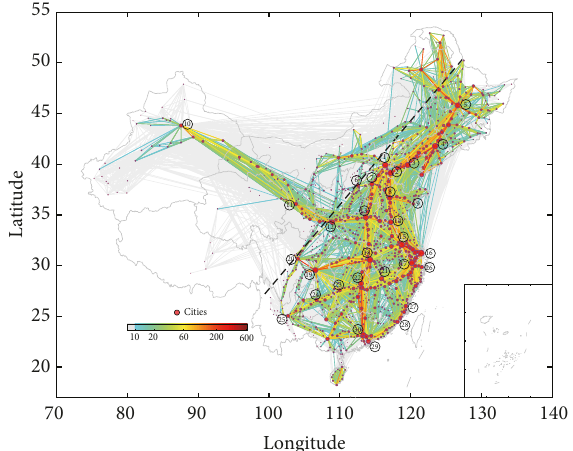
Figure 3: The spatial distribution of train flows in CRN. The size of the nodes reflects the degree of the city, and the colors of the lines indicate train flows. The black dashed line denotes the Hu Line, which demarcates the concentration of population of China. Cities along the four vertical and four horizontal railway corridors